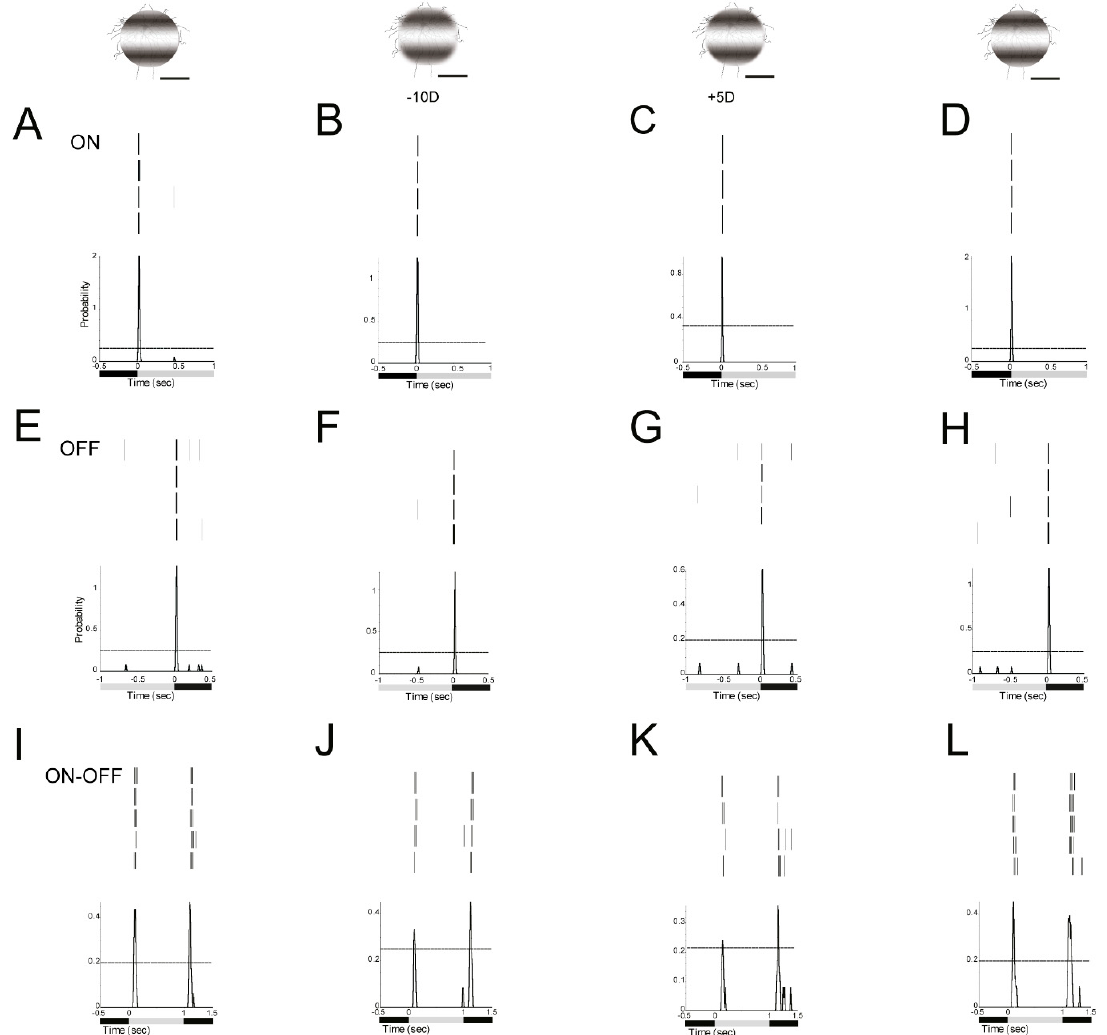
Figure 5. Defocused images altered the signaling responses in RGCs. A , E and I ; ON, OFF α -RGC and ON–OFF RGC response to 1 s 0.002 cycles/degree light stimuli (I = 5.09 x10 4 Rh*/rod/sec). B , F and J ; ON, OFF α -RGC and ON–OFF RGC light responses decreased after a defocused image was projected. The peristimulus time histogram of the ON α -RGC ( A ) showed that the probability of spikes decreased from 2.05 to 1.25 (-10D defocus) ( B ) and to 0.94(+5D defocus) (C) . Then the probability of spikes recovered with refocused image ( D ). Similar, OFF α -RGC ( E ) decreased from 1.4 to 1.2 (-10D defocus) (F) and to 0.6(+5D defocus) ( G ). The probability of spikes recovered with refocused image ( H ). ON–OFF RGC (I) ON response decreased from 0.44 to 0.27 (-10D defocus) ( J ) and to 0.22(+5D defocus) ( K ); OFF response decreased from 0.47 to 0.44 (-10D defocus) ( J ) and to 0.37 (+5D defocus) ( K ). Then the probability of spikes recovered with refocused image ( L ). Scale bar: 75 µm.